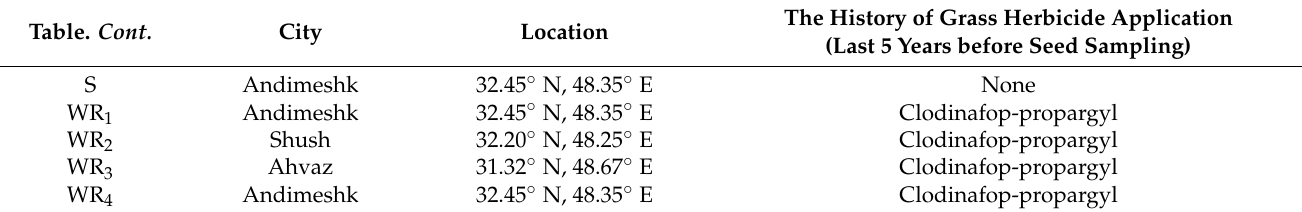
The History of Grass Herbicide